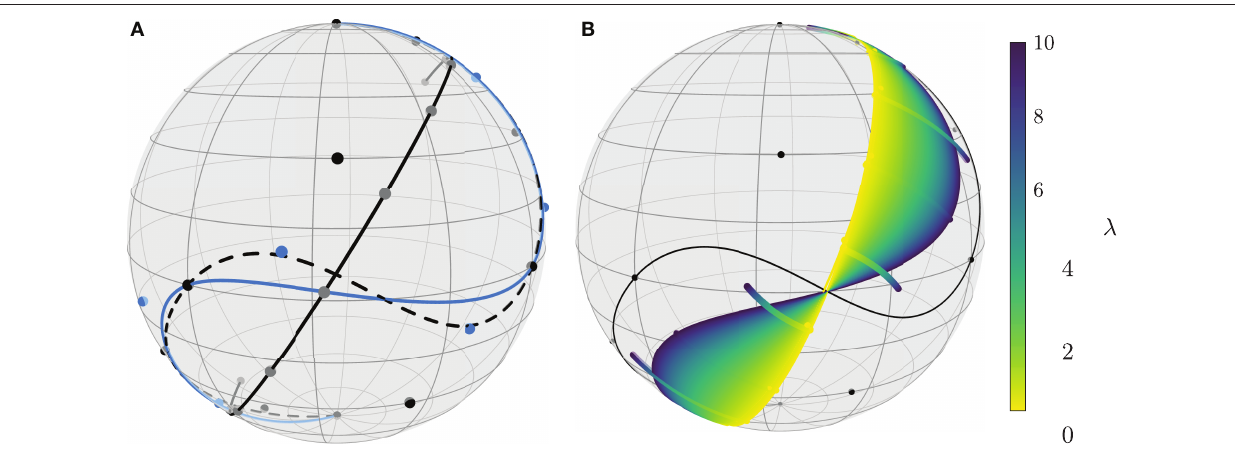
0 yields an unconstrained =